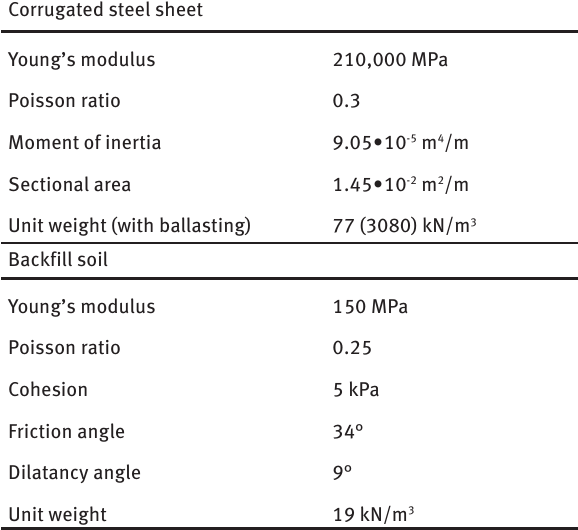
Table 1: Mechanical parameters used in the